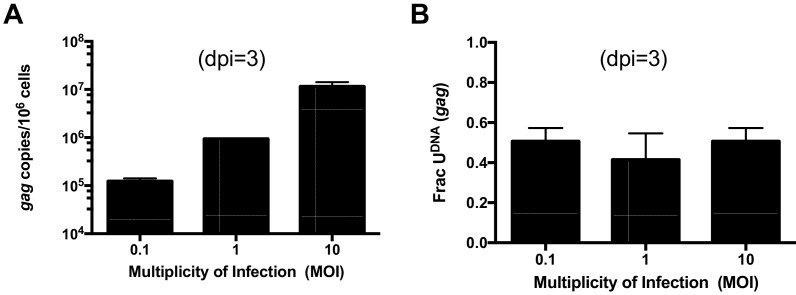
Uracilation is independent of multiplicity of infection (MOI).MDMs were infected with HIVNL4.3(VSVG) using MOIs of 0.1, 1 and 10. (A) The viral gag copy number increases with MOI. (B) The MOI does not significantly affect the fraction of viral gag copies that contained uracil. Number of experimental repetitions (n = 3) and errors are reported as mean ± SD.